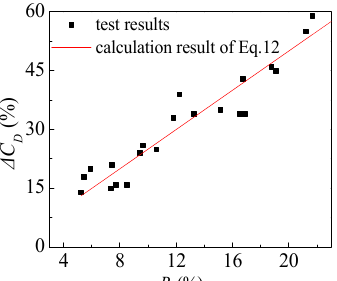
Figure 20. The relationship between Δ C D and the equivalent blockage ratio.